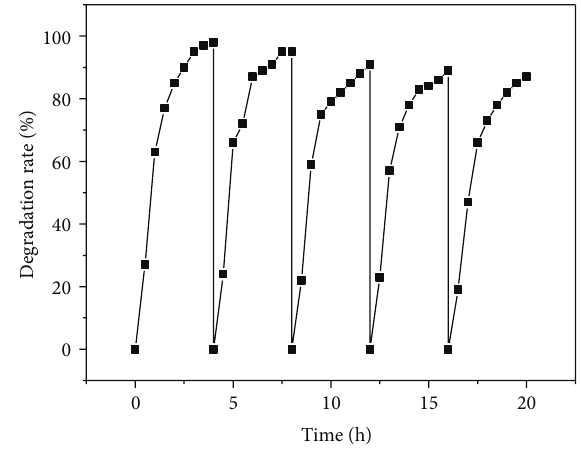
Figure 11: Recycling of the catalyst.